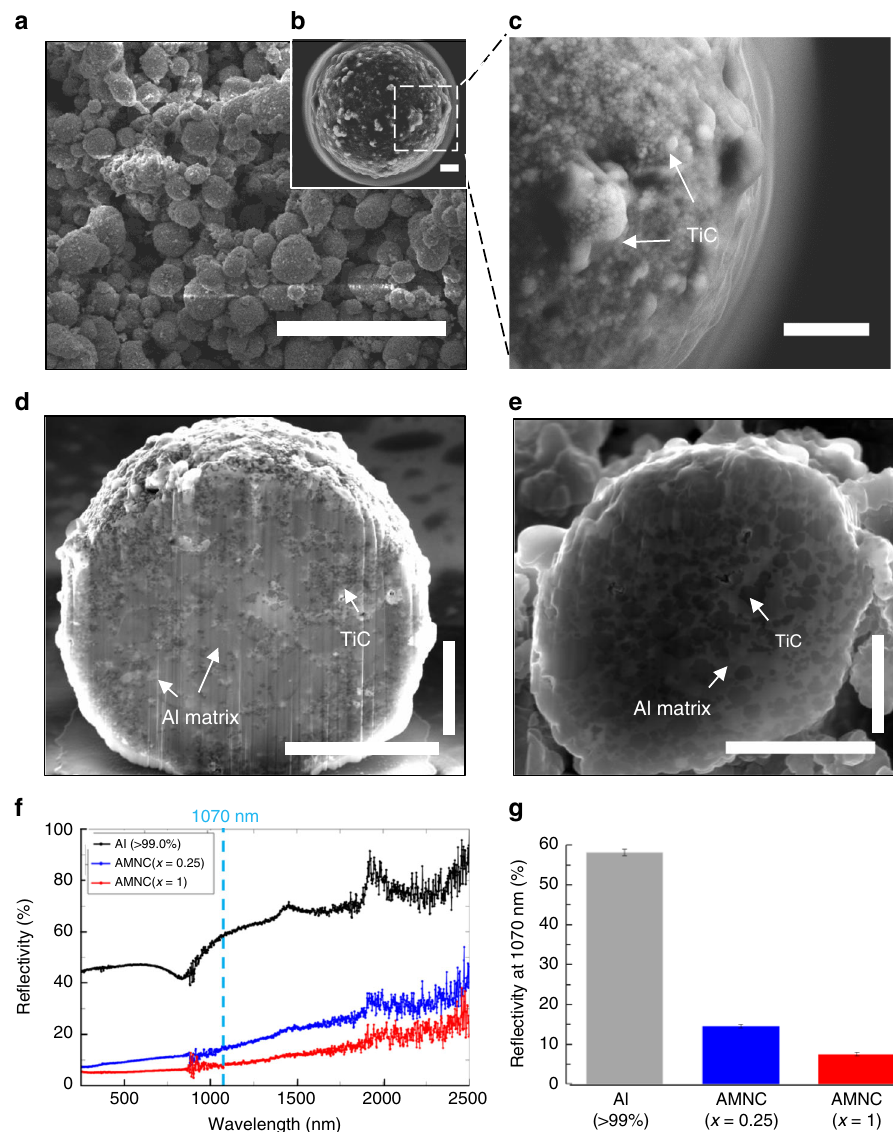
Fig. 1 Morphology, microstructure and re fl ectivity of aluminum matrix nanocomposite (AMNC) powders. a , b SEM images of AMNC powders with x = 0.25. c Magni fi ed image of b , showing TiC nanoparticles coated on the surface of an Al micro particle. d , e SEM images of the cross sections of specimens with x = 0.25 and x = 1, respectively. The AMNC powders ( x = 1) have a higher loading of embedded TiC nanoparticles than the AMNC powders ( x = 0.25). f Re fl ectivity of aluminum powders without and with nanoparticles. The dashed vertical line indicates the laser wavelength at 1070 nm. g Comparison of the re fl ectivity at the wavelength of 1070 nm for aluminum powder specimens with and without nanoparticles. Scale bar, 40 µ m in a , 1 µ m in b , c , e , and 4 µ m in d . The error bars in the measured re fl ectivity are the standard deviations (s.d.) calculated over three